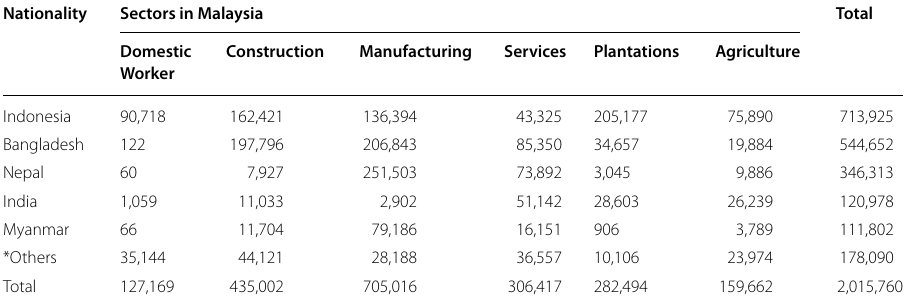
*Include such countries as Pakistan, the Philippines, Vietnam, China, Thailand, Sri Lanka, Cambodia and Laos Source: Ministry of Human Resources (MOHR),